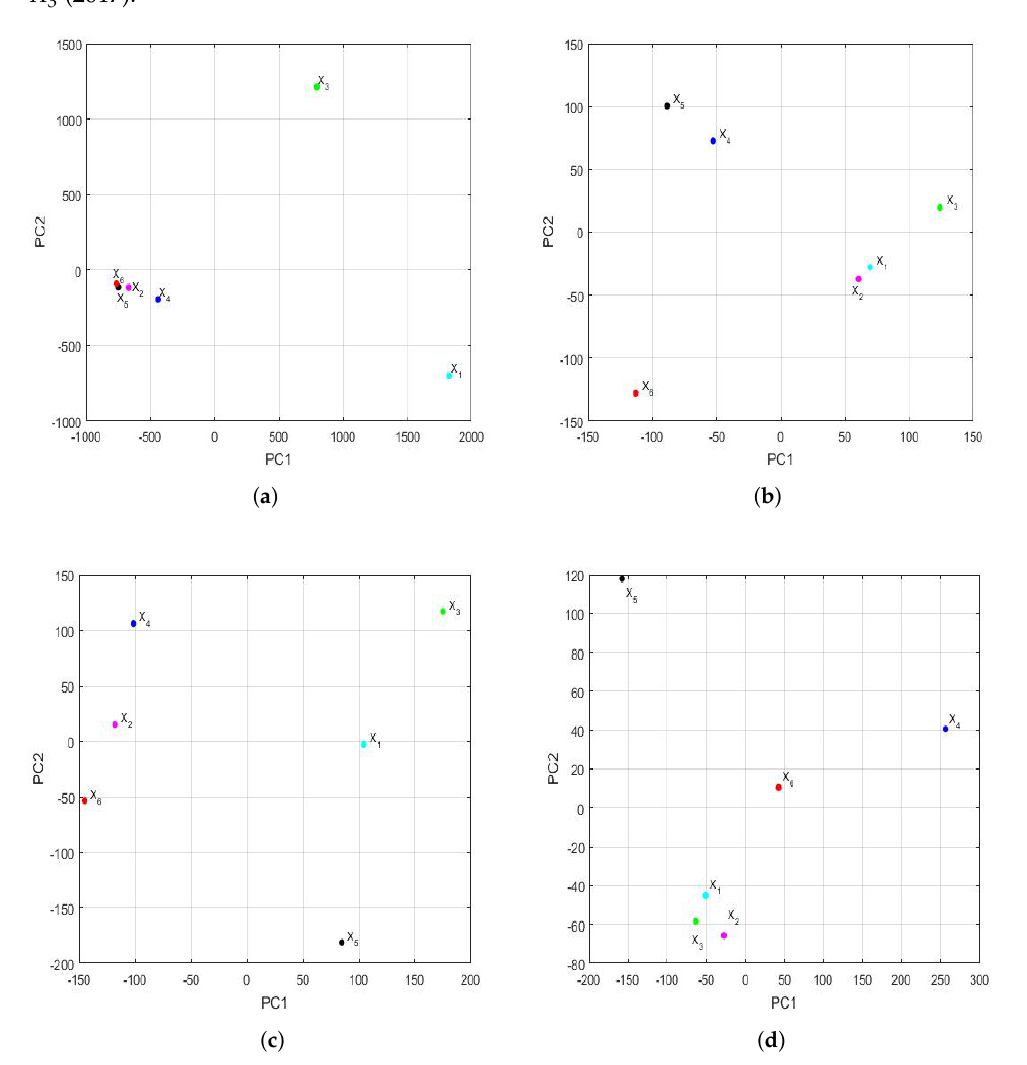
Figure 19. First two principal components of the feature vectors by trimesters of each of the years of of the first trimester. ( b ) Feature vectors: first 2 principal components of the second trimester. ( c ) Feature vectors: first 2 principal components of the third trimester. ( d ) Feature vectors: first 2 principal components of the fourth